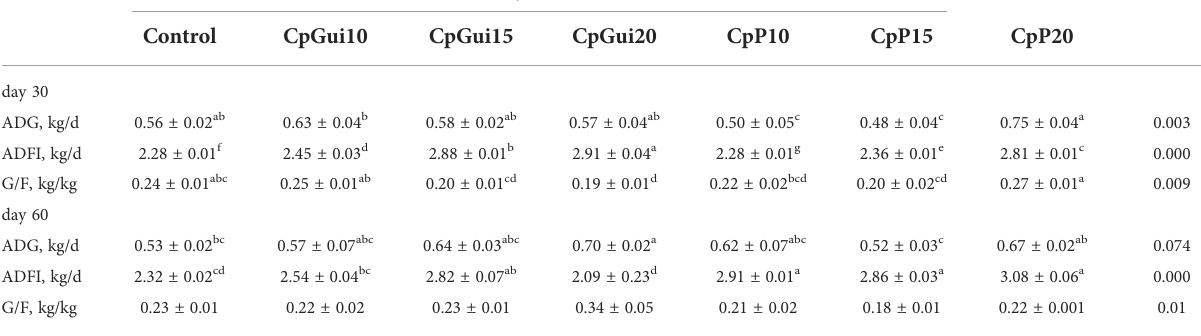
TABLE 2 Growth performance of pigs with different feed composition